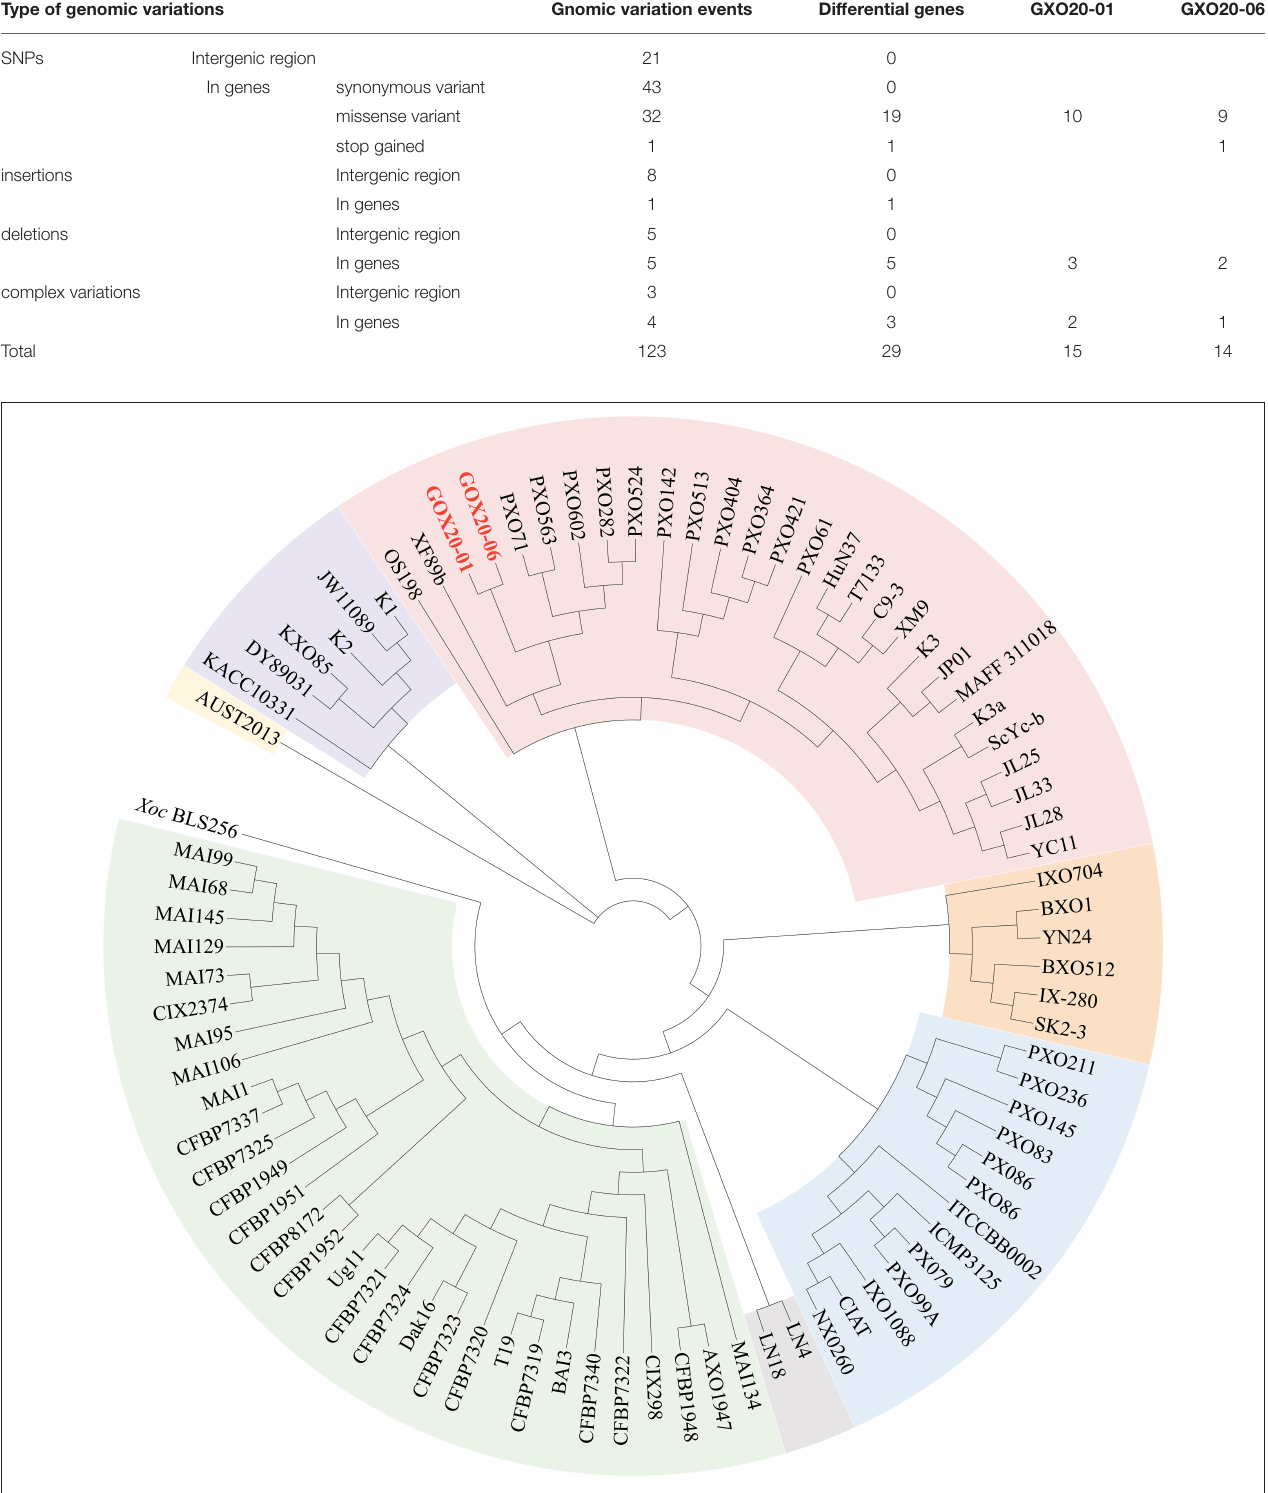
Frontiers in Microbiology |